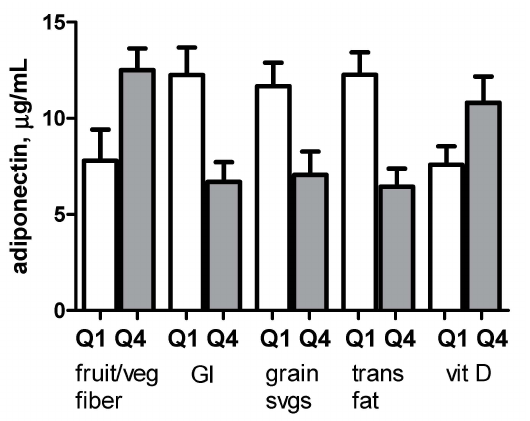
Figure 2. Adiponectin concentrations among individuals in lowest and highest gender-specific quartile for each dietary component. Mean and SEM of adiponectin concentrations for individuals in the lowest (Q1, white bar) and highest (Q4, shaded bar) gender-specific quartile for intake of each dietary factor. GI, glycemic